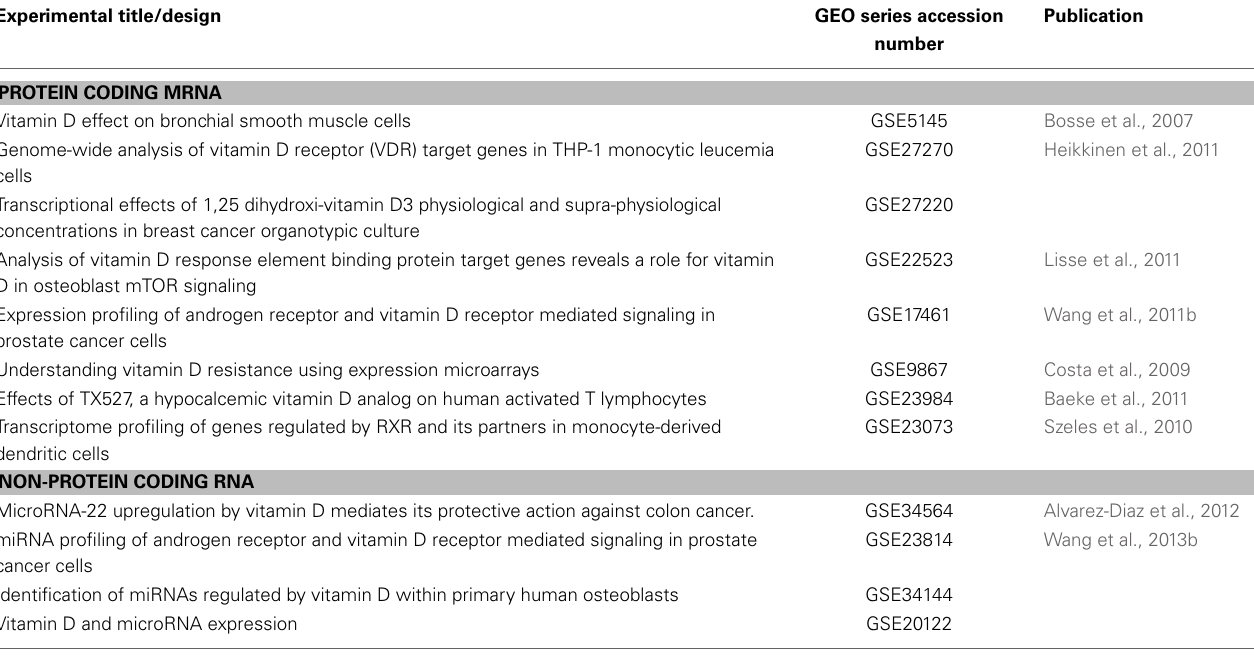
Table 2 | Publically available MIAME compliant microarray studies of VDR